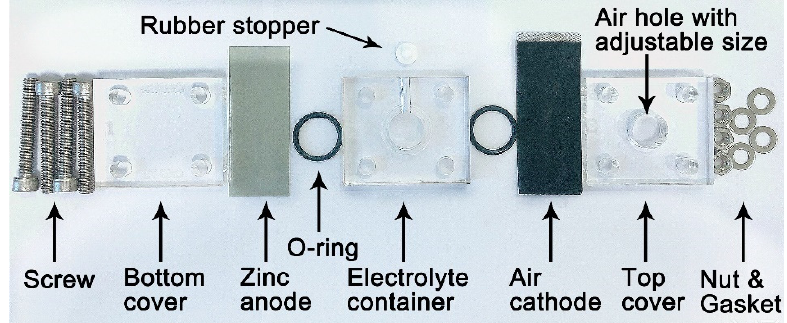
Figure 1. Component images of a unit type zinc–air battery.